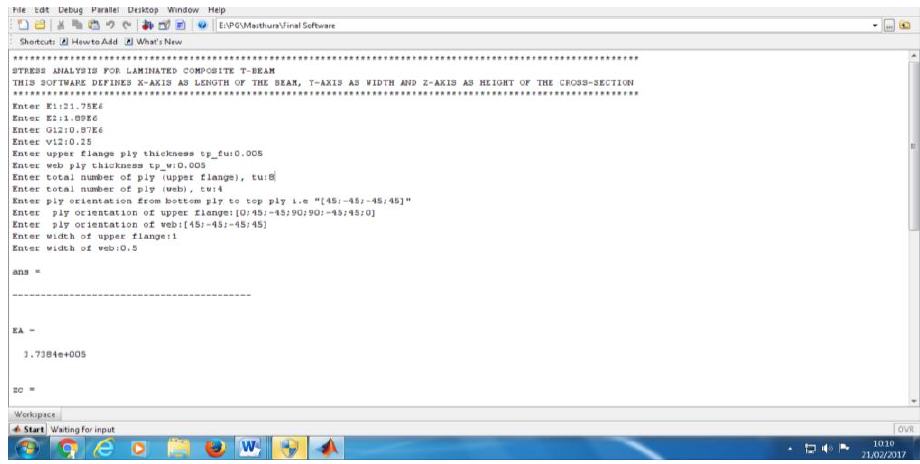
Figure 3: Typical input/output window for the MATLAB